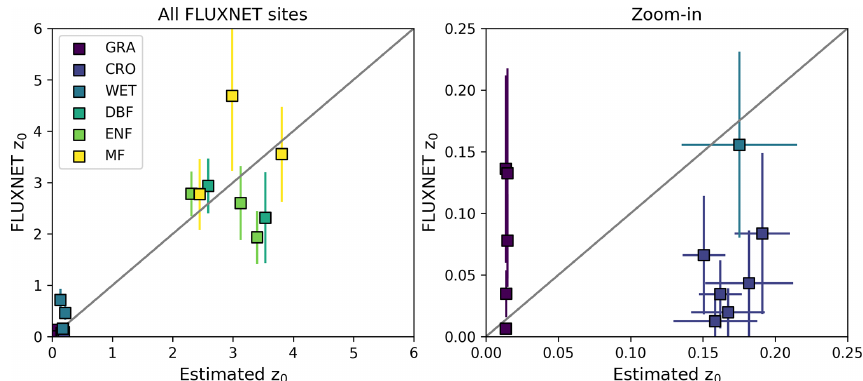
Figure 4. Comparison of the updated z 0 values ( x axis) to the z 0 values derived from EC measurements ( y axis). The error bars indicate the standard